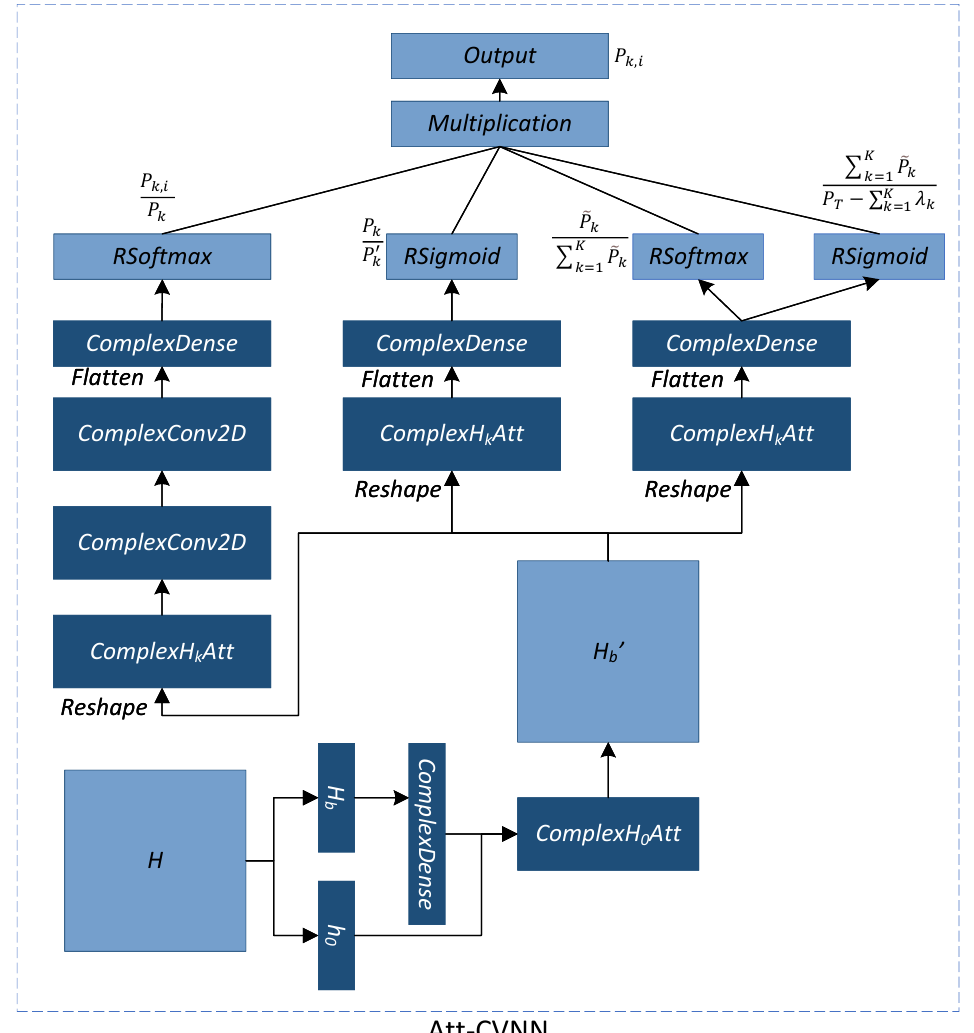
Figure 2. The structure of the complex-valued power allocation neural network